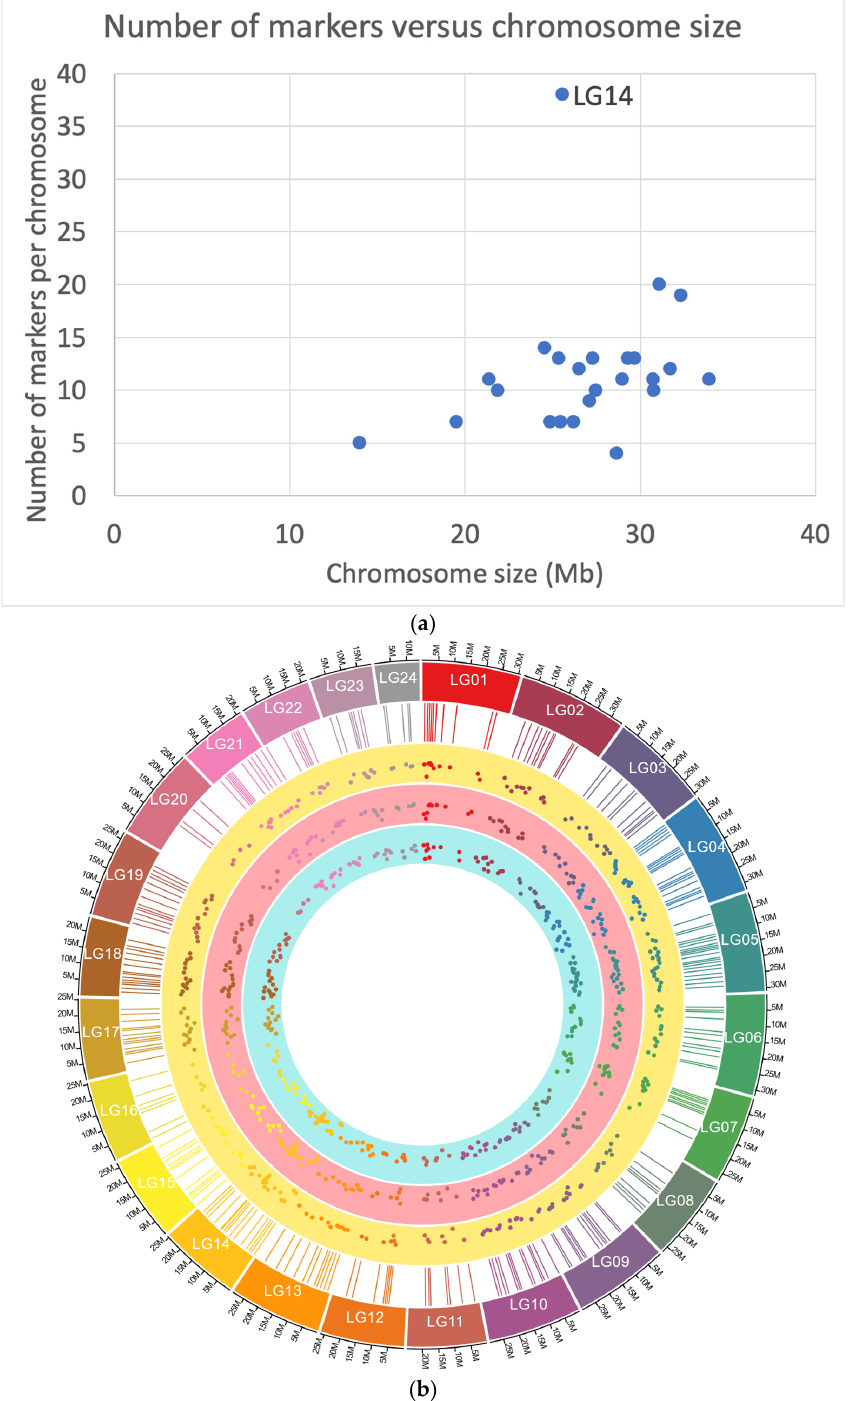
Figure 1. ( a ) Number of markers per chromosome (Y-axis) versus chromosome (linkage group: LG) size in Mb (assume 1cM equals Mb: X-axis). The linkage group 14 (LG14) included the markers for sex determination. ( b ) Markers used for the GBS panel and MAF. The outer layer shows the genome, the second layer (rectangle) shows the position of the markers, while the third, fourth, and fifth layers the observed MAF for the New Zealand and Chilean populations.